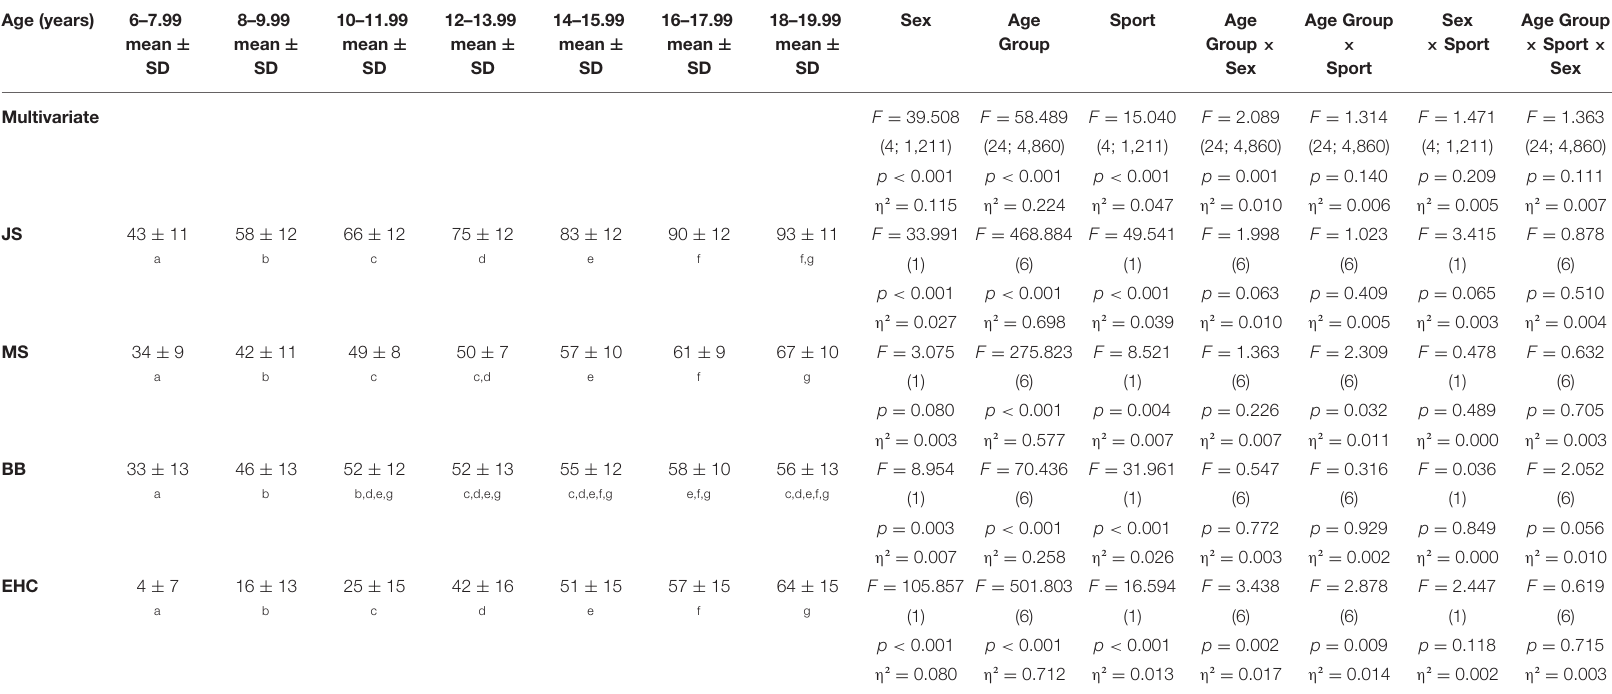
TABLE 3 | Means and standard deviations (SD) from the raw scores on each KTK3 + test battery for the age categories, with the F , ( df ), p , and partial η ² -values of the